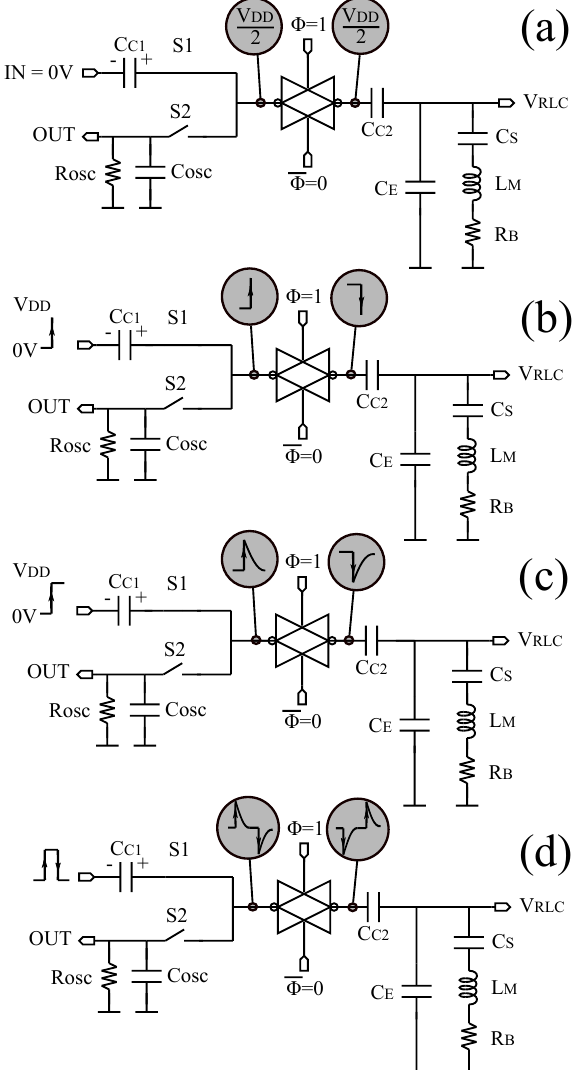
Figure 9. Analysis of the input and output signals of the bidirectional amplifier. ( a ) at the beginning of the actuation mode the system is in equilibrium; ( b ) occurrence of the rising edge of the input pulse; ( c ) feedback reaction of the front-end; ( d ) occurrence of the falling edge of the input pulse and feedback